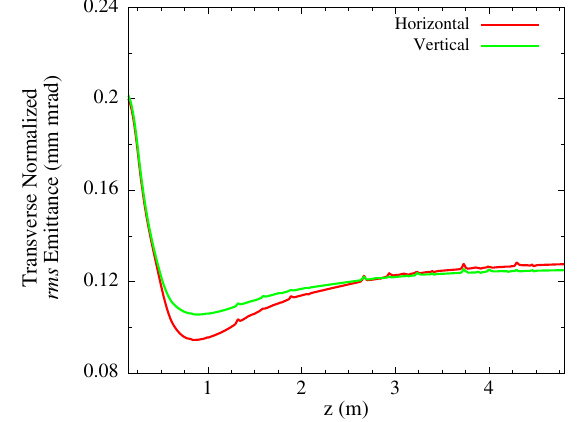
FIG. 10. Transverse normalized rms emittances of the bunch off the cathode tracked through an unoptimized version of the accelerating section as a function of the longitudinal position.